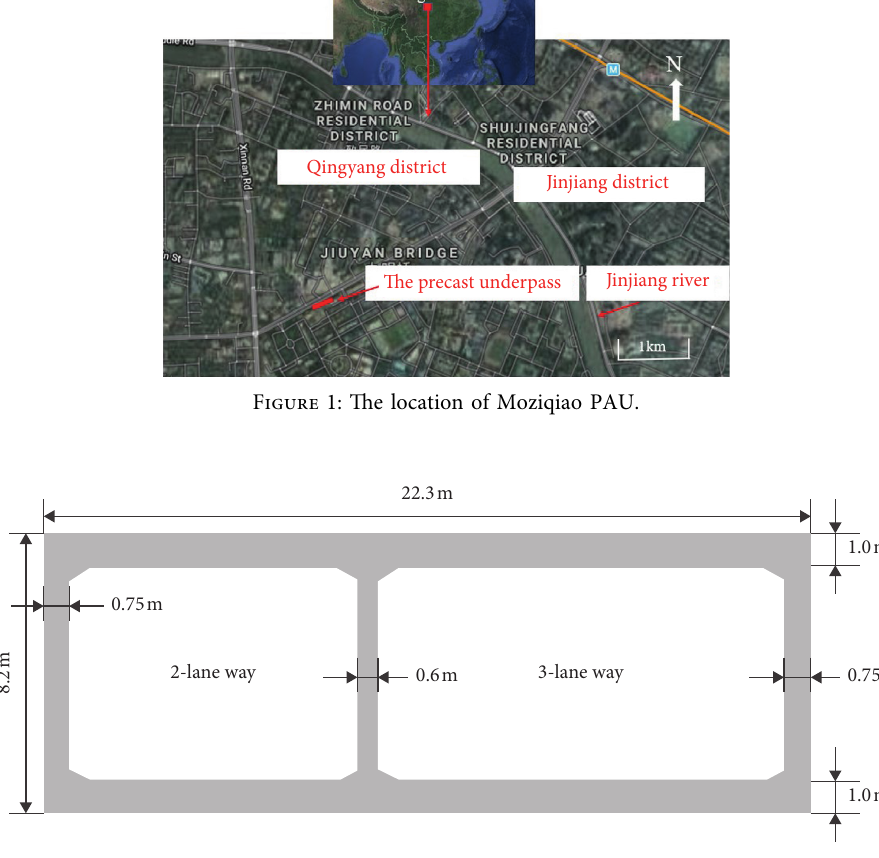
Figure 2: Cross-sectional dimensions of the